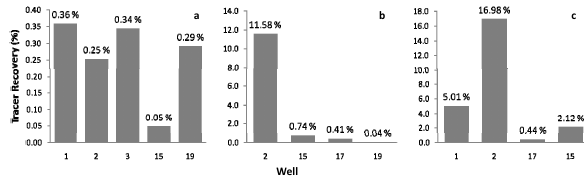
Fig. 10. Mass recovery of tracer for no-salt test EC (a) , salt-added test EC (b) , and salt-added test chloride (c)